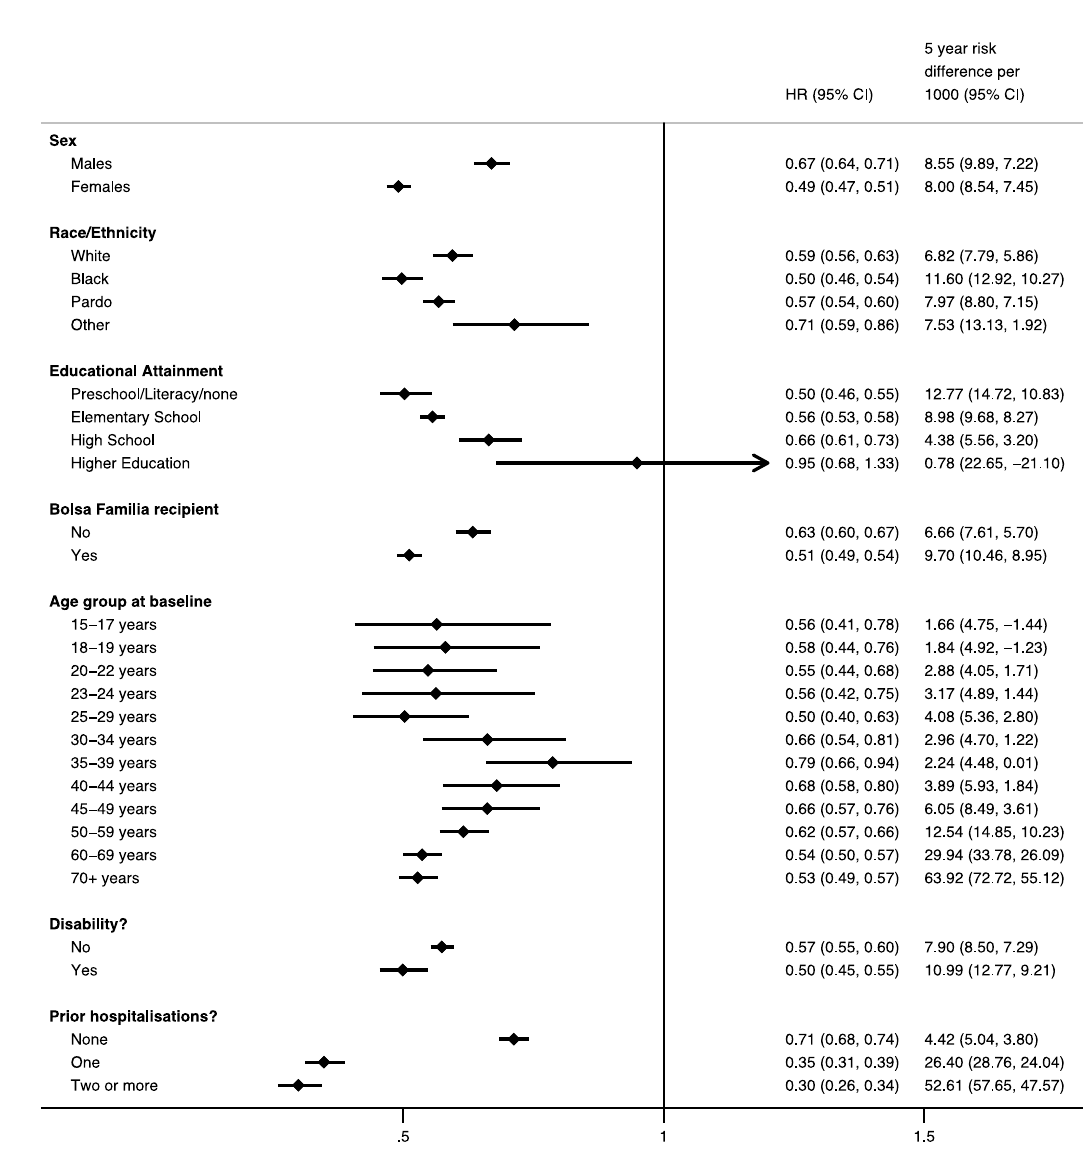
Fig 4. Subgroups analysis showing HRs and 5-year RDs from FHS usage on time until death from any cause. Estimated HRs and risk differences RDs obtained from flexible parametric survival models with IPTW and regression adjustment for sex, race/ethnicity, age at cohort entry, highest level of education, disability, unemployment, household per capita income decile, number of family members per bedroom, family size, number of children in family, household flooring, household piped water access, quintiles of household expenditure on medicines, quintile of per capita household expenditure on food, formal labor employment, formal labor employment in the family, whether the family receives Bolsa Familia or not, and whether the individual has been hospitalized before FHS use. A separate model was carried out for each subpopulation. Five-year RD estimated risk of death using mean survival curves. HRs and RD interpreted relative to a mean time since FHS usage of 2.6 years. FHS, Family Health Strategy; HR, hazard ratio; IPTW, inverse probability treatment weighting; RD, risk